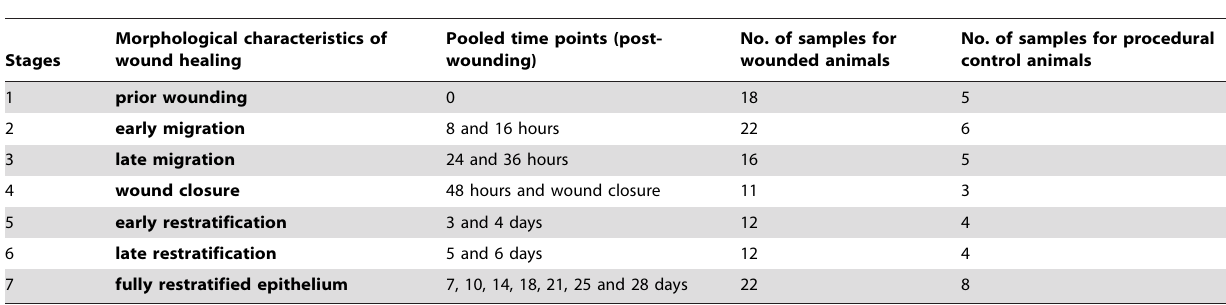
Table 1. Tear sample grouping based on wound healing stages for both wounded and procedural control eyes.